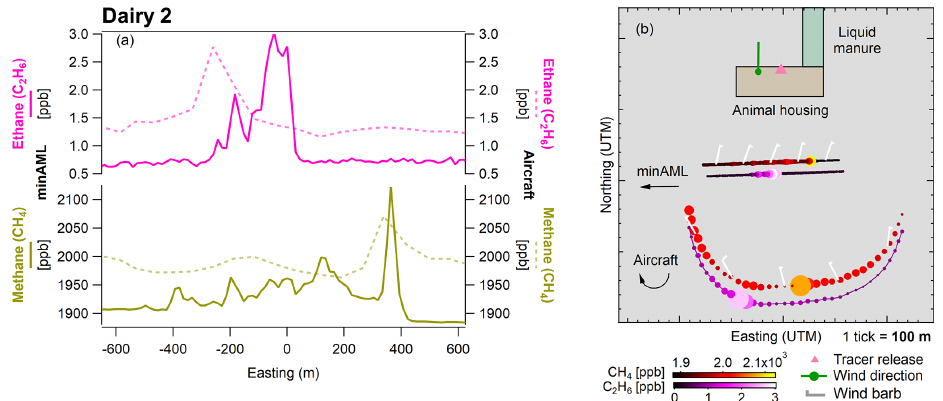
Figure 3. Plumes observed by the miniature Aerodyne Mobile Laboratory (minAML) and aircraft. Plots of methane (CH 4 ) and ethane (C 2 H 6 ) are overlaid for each platform (a) . Observations occurred during transects by each vehicle to the south of Dairy 2, during a release of C 2 H 6 into a southerly wind (b) . Potential emission sources on the farm have been identified as colored sections, though not as an exact scaled representation.